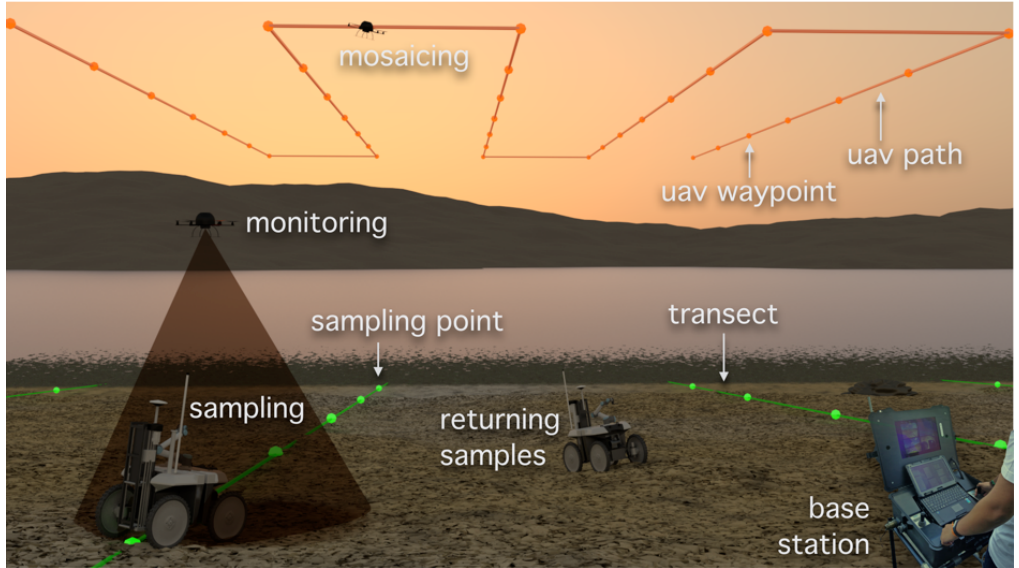
Figure 3. Diagram representing the sediment sampling mission